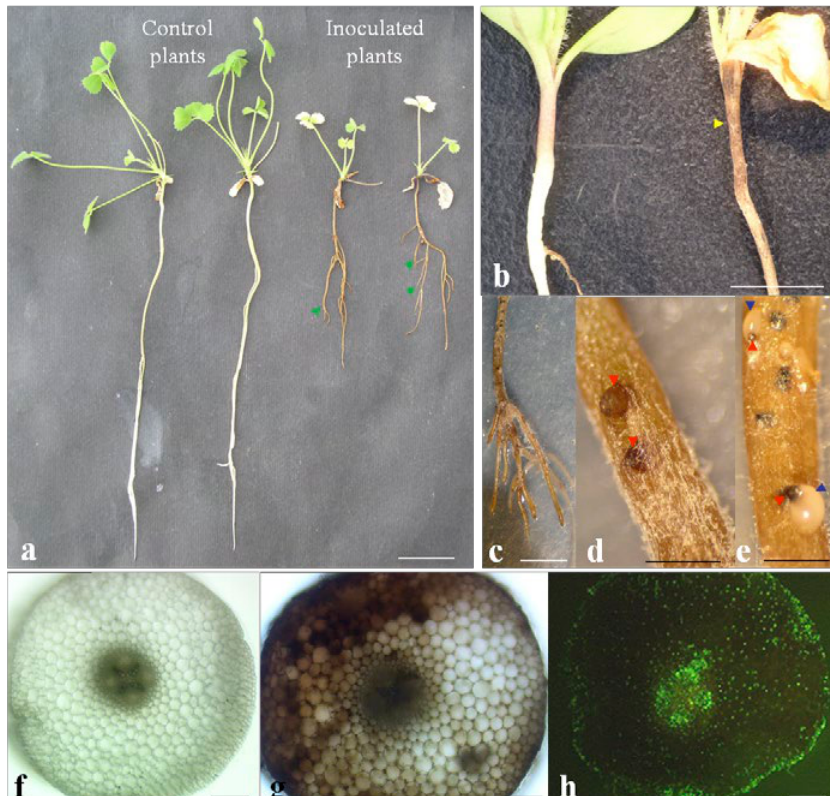
Figure 2. (a‒b) Symptoms of Phoma medicaginis infection on Medicago truncatula roots and collar (line F83005.5) 15 days post inoculation. (c‒e) Pycnidia of P. medicaginis on F83005.5 infected root. (f‒h) Micrographs of sections of M. truncatula infected roots with P. medicaginis taken with light (f‒g) and epifluorescence (h) microscopes. The infection appeared on the principle and lateral roots (green arrows in a) and on the collar (yellow arrow in b). Pycnidia were produced on dead roots (red arrow in d and e) which lead to the production of pycnidiospores (blue arrows in e). Cross-sections of inoculated roots were stained with wheat germ agglutinin-fluorescein isothiocyanate to visualize fungal mycelia (green color in h). Bars correspond to 5 cm (a), 1 cm (b‒c), 1 mm (d‒e) and 100 µm